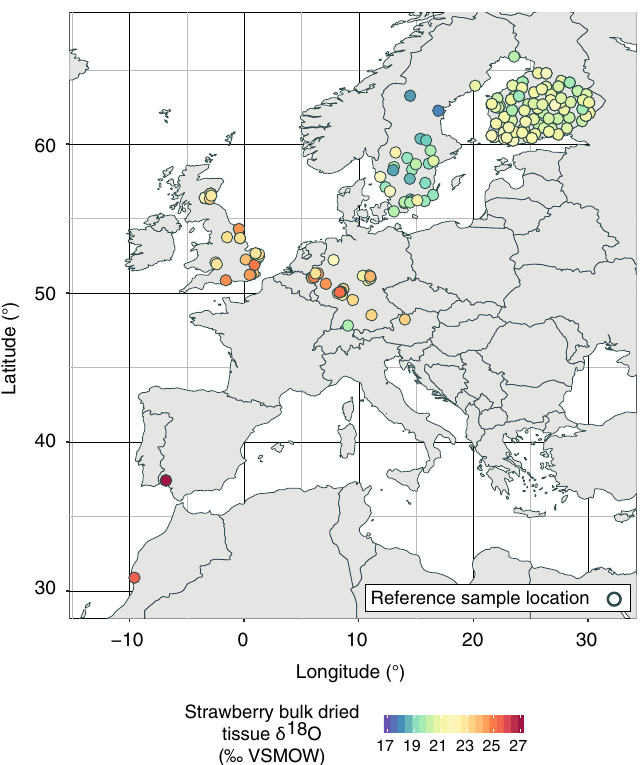
Figure 1. Map of Europe, showing the locations of the 154 authentic reference samples used for the model validation. The samples were collected between 2007 and 2017. The colored fill of the dots shows the measured δ 18 O values of the strawberry bulk dried tissue of the reference samples. The samples were mainly collected during the main European strawberry season from May to July 76 . The map was created using the software R, version 3.5.3 (https:// www.r- proje ct.